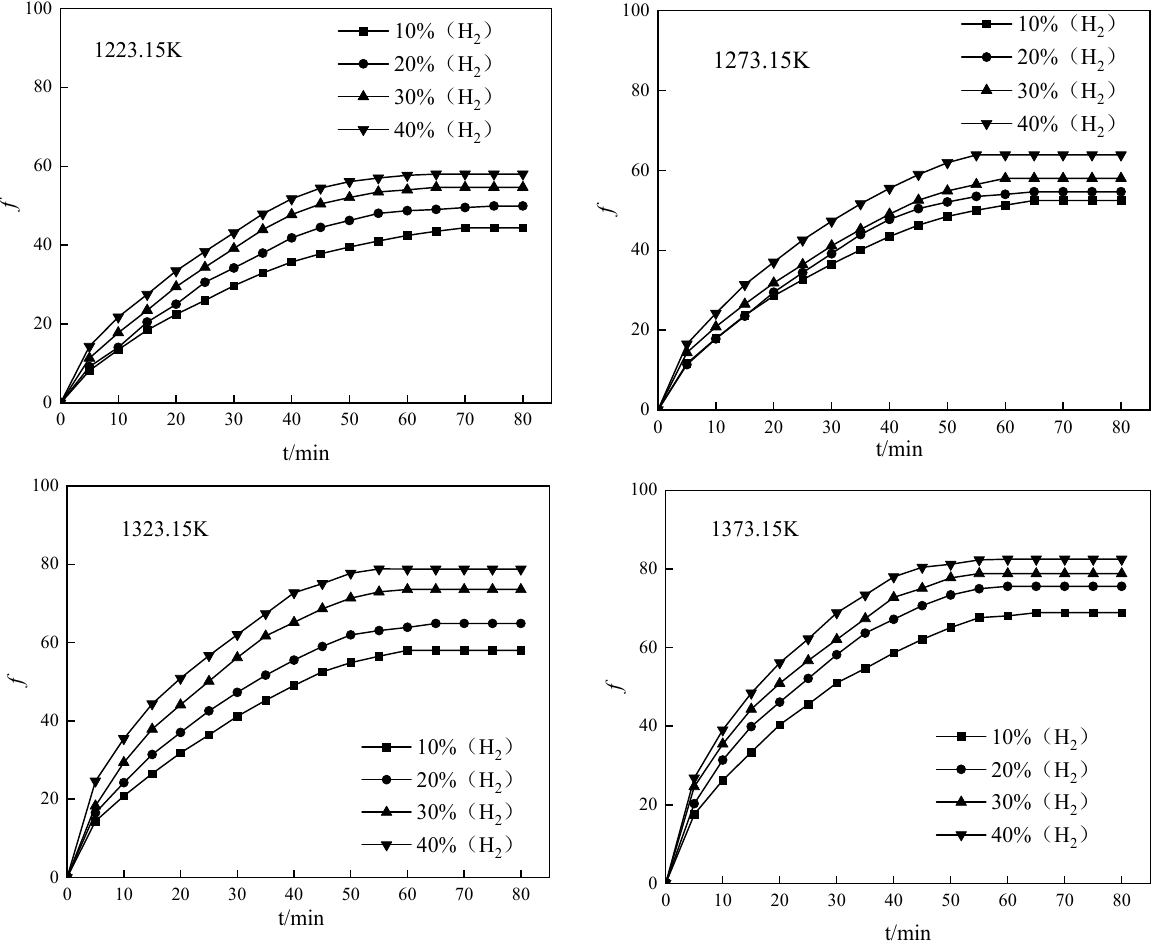
Figure 9. Experimental results under different conditions.